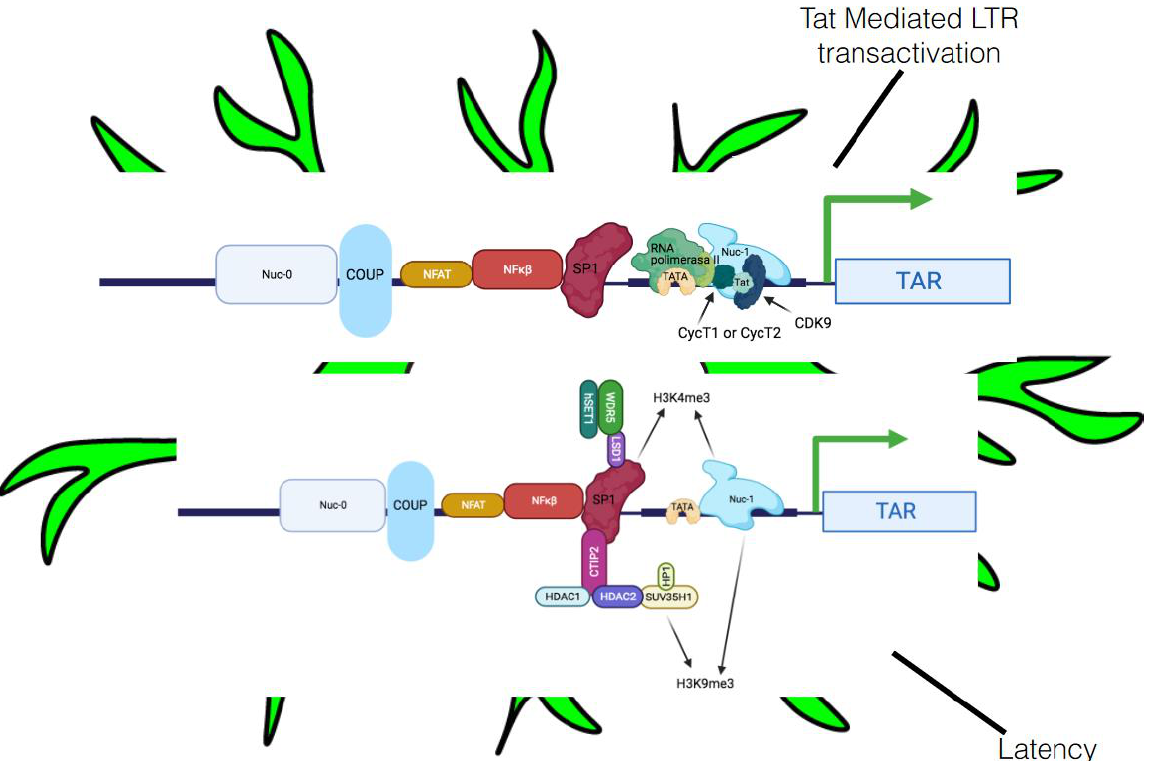
Figure 3. A model of post-integration latency in HIV-1-infected microglia. Post-integration latency is manifested through several mechanisms, including chromatin remodeling, epigenetic mechanisms, and host-encoded miRNAs. Histone deacetylase 1 (HDAC1) causes chromatin remodeling, which is responsible for the inhibition of HIV-1 gene expression. C- promoter binding factor-1 (CBF-1) and COUP-TF-interacting protein 2 (CTIP2) have also been implicated in the recruitment of HDACs to the pr-oviral promoter, thereby establishing latency. Moreover, Tat can mediate reactivation of this process. Integrated HIV-1 pro-viral DNA is also delimited at both ends by the HIV-1 LTR. The 5′ LTR has unique blend of